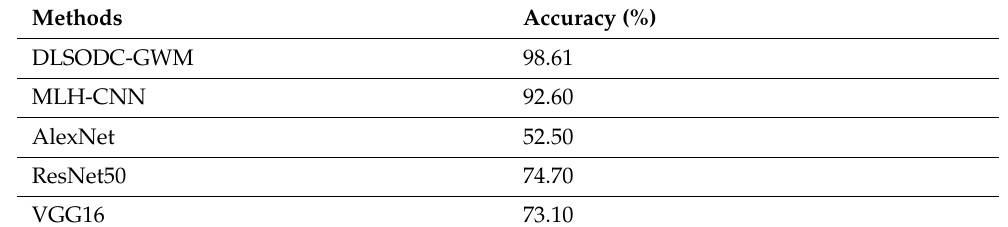
Table 3. Accuracy analysis of DLSODC-GWM technique with recent methods.